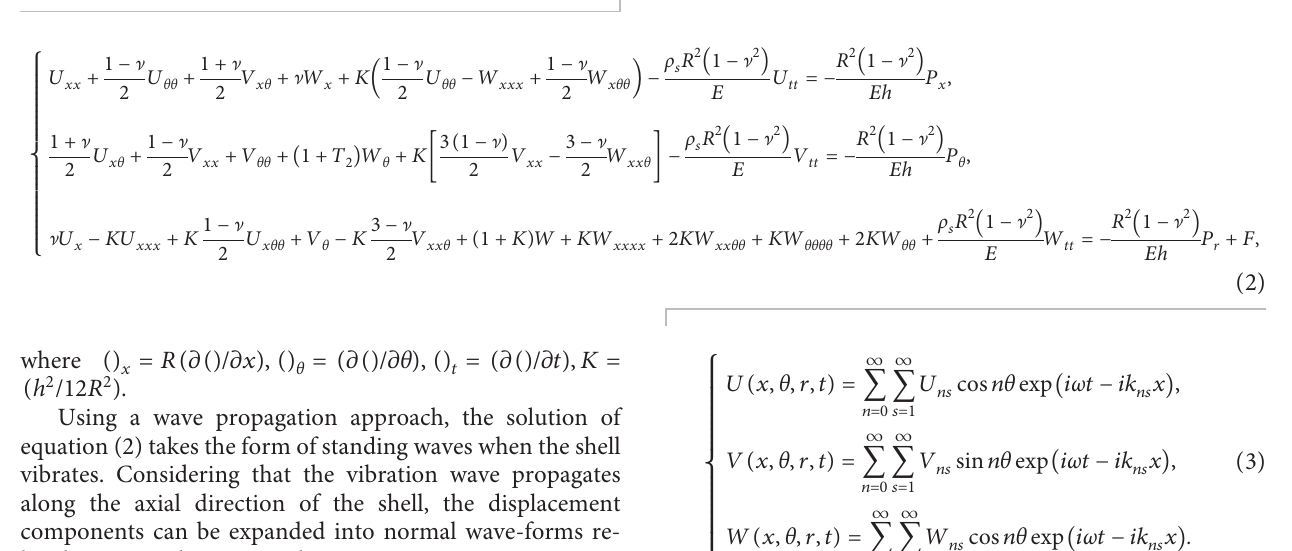
The coordinate axis x is chosen to coincide with the cy- lindrical shell centerline while the coordinate axes r and θ are taken along the radial and circumferential